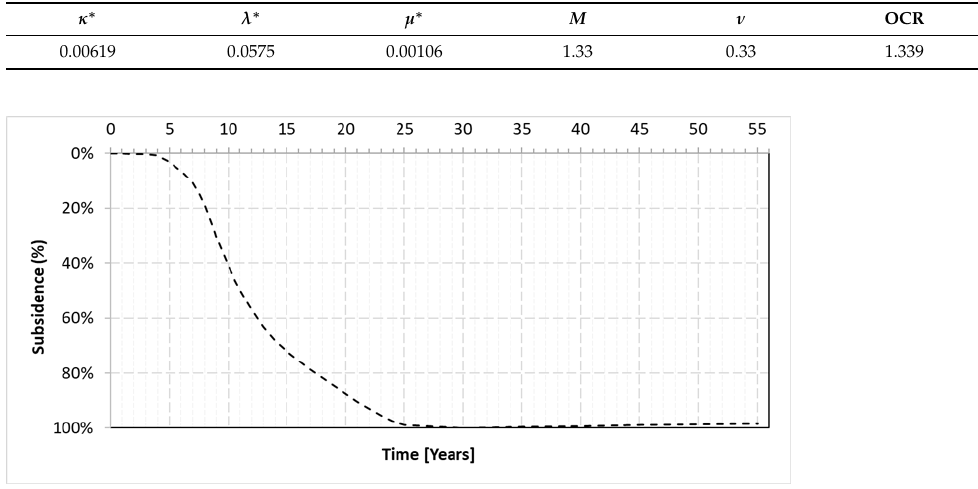
Table 3. Parameters for the V-N law for the real case study.